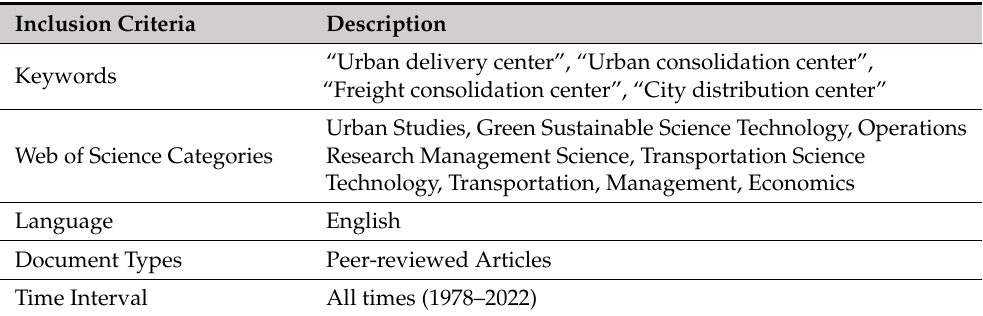
Table 1. Keywords used for bibliometric analysis.